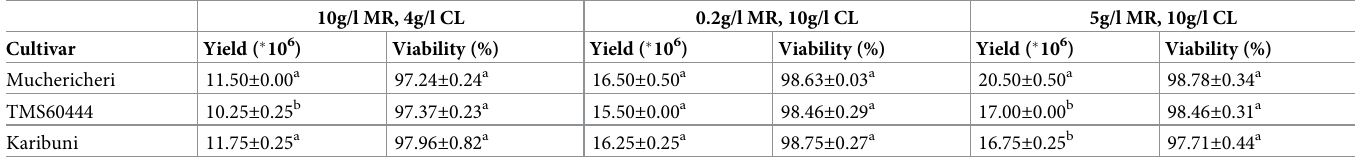
Table 1. Effects of macerozyme and cellulase enzymes combination ratio on yield and viability of cassava protoplast.